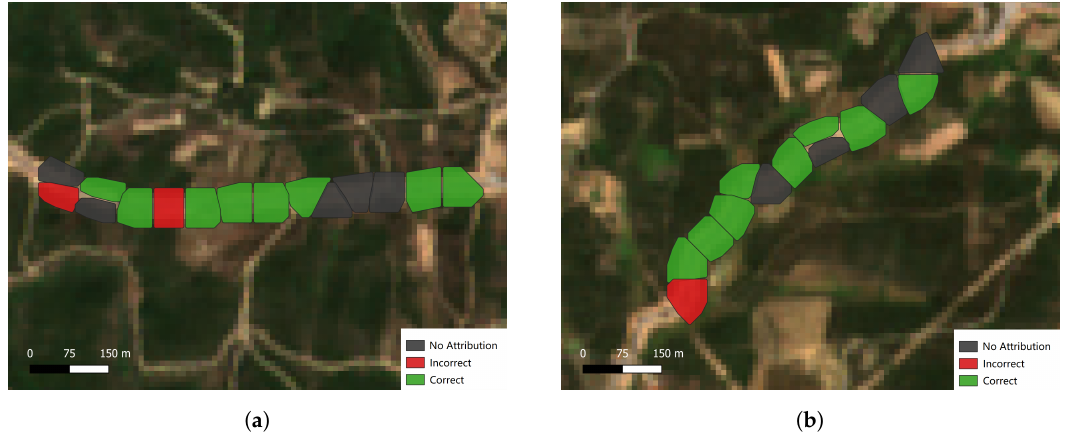
Figure 17. Intervention date forecast results for Site A ( a ) and Site B ( b ). Presented in red where the estimate was wrong, in green where it was correct, and in black which did not obtain